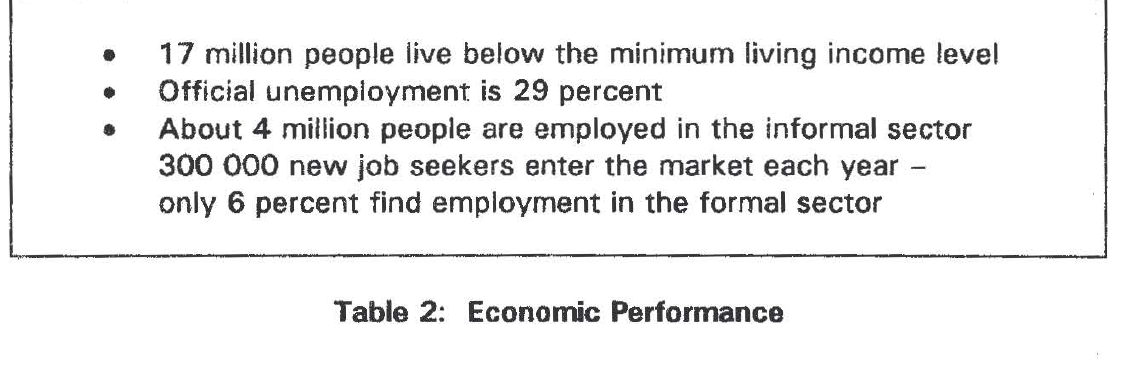
Table 2: Economic